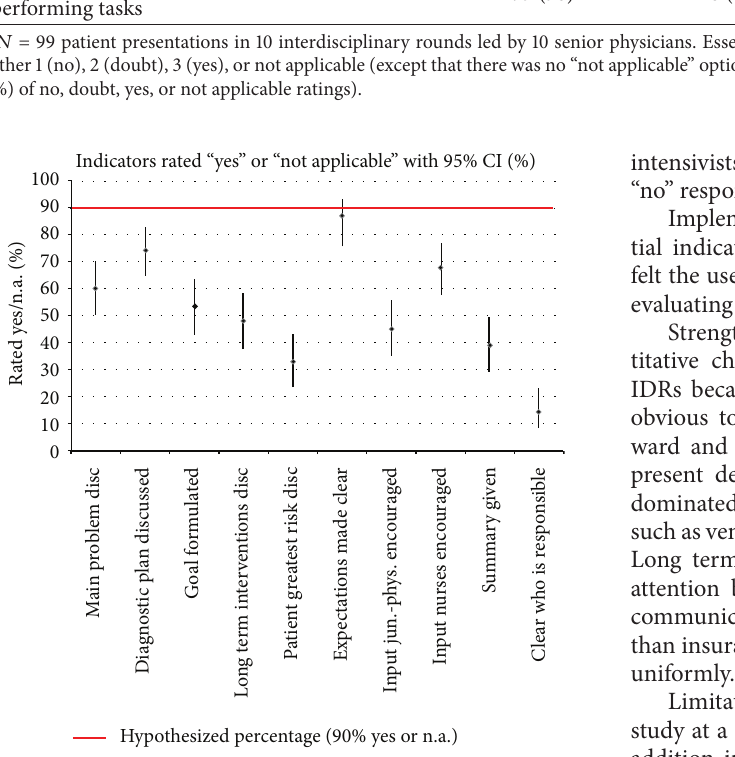
Figure 1: Results of the differences between the hypothesized and saturated model (with 95% confidence interval), with 99 patient presentations during 10 interdisciplinary rounds by 10 leading